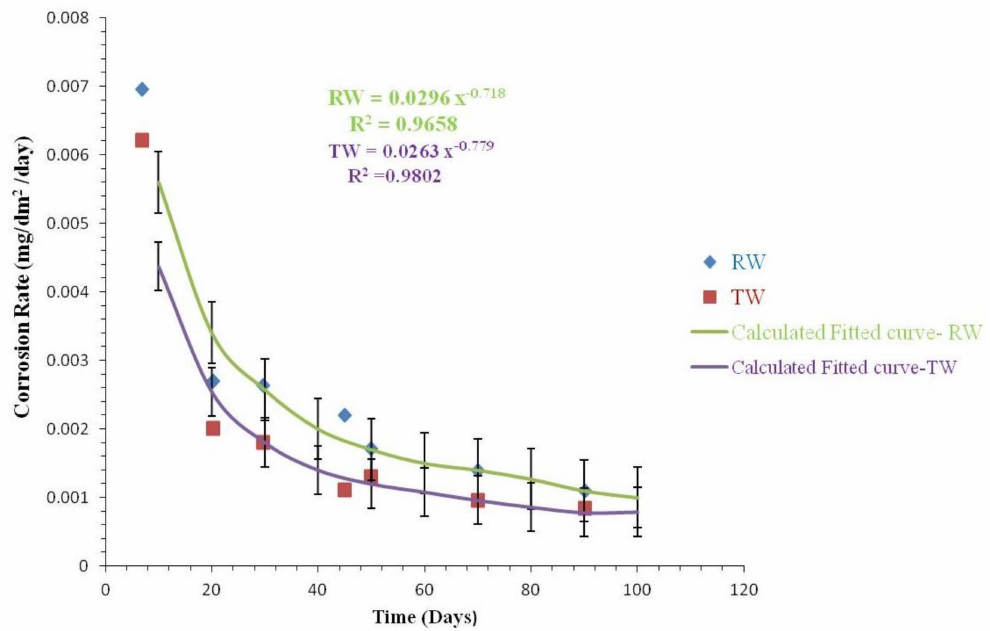
Figure 19. Corrosion rate of stainless steel pipe coupons with RW and TW over time with standard error